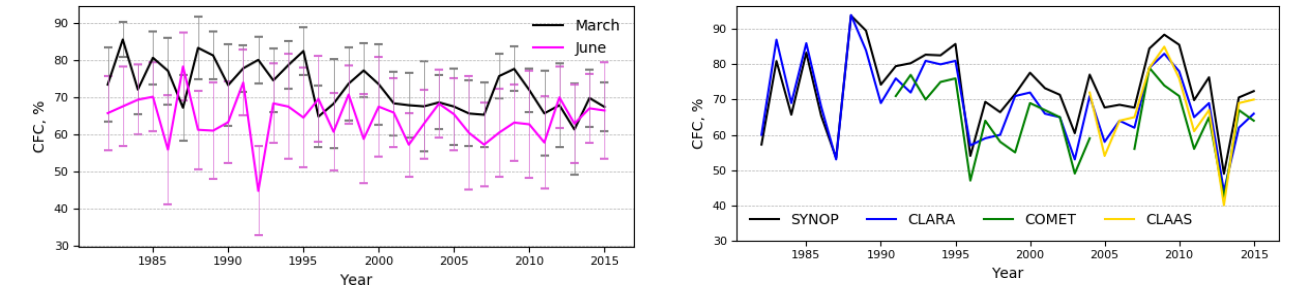
Figure 2. Monthly average CFC over the entire region 1982 to 2015 for March (black) and June (magenta) from CLARA-A2 with SDs.